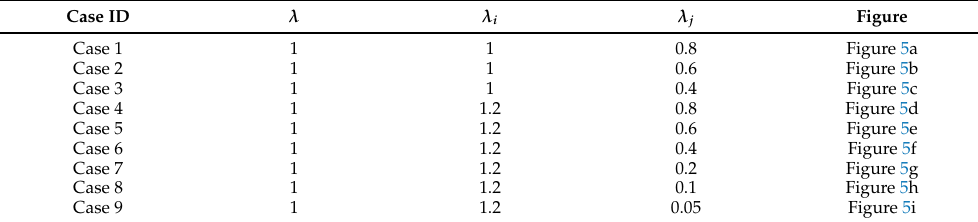
Table 2. Setting of the arrival rates in the network model with unequal